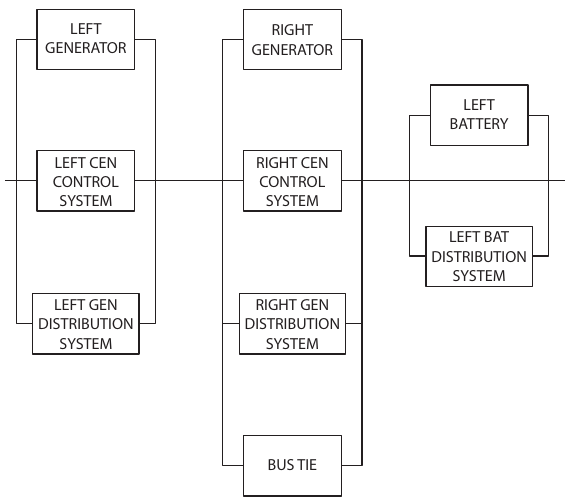
Fig. 3. Failure of one main bus supply block